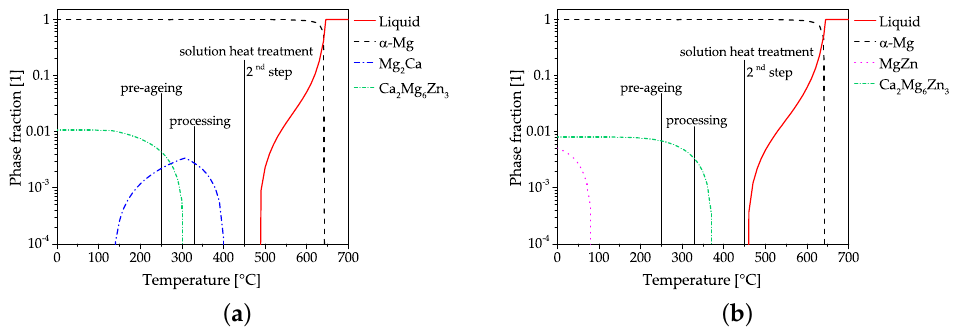
Figure 9. CALPHAD calculations, including the used processing temperatures, of two biodegradable Mg–Zn–Ca alloys. Calculations were made, using the alloy compositions given in ref.[86]; for further information see Appendix A.2. ( a ) Mg-1.0Zn-0.3Ca; ( b )